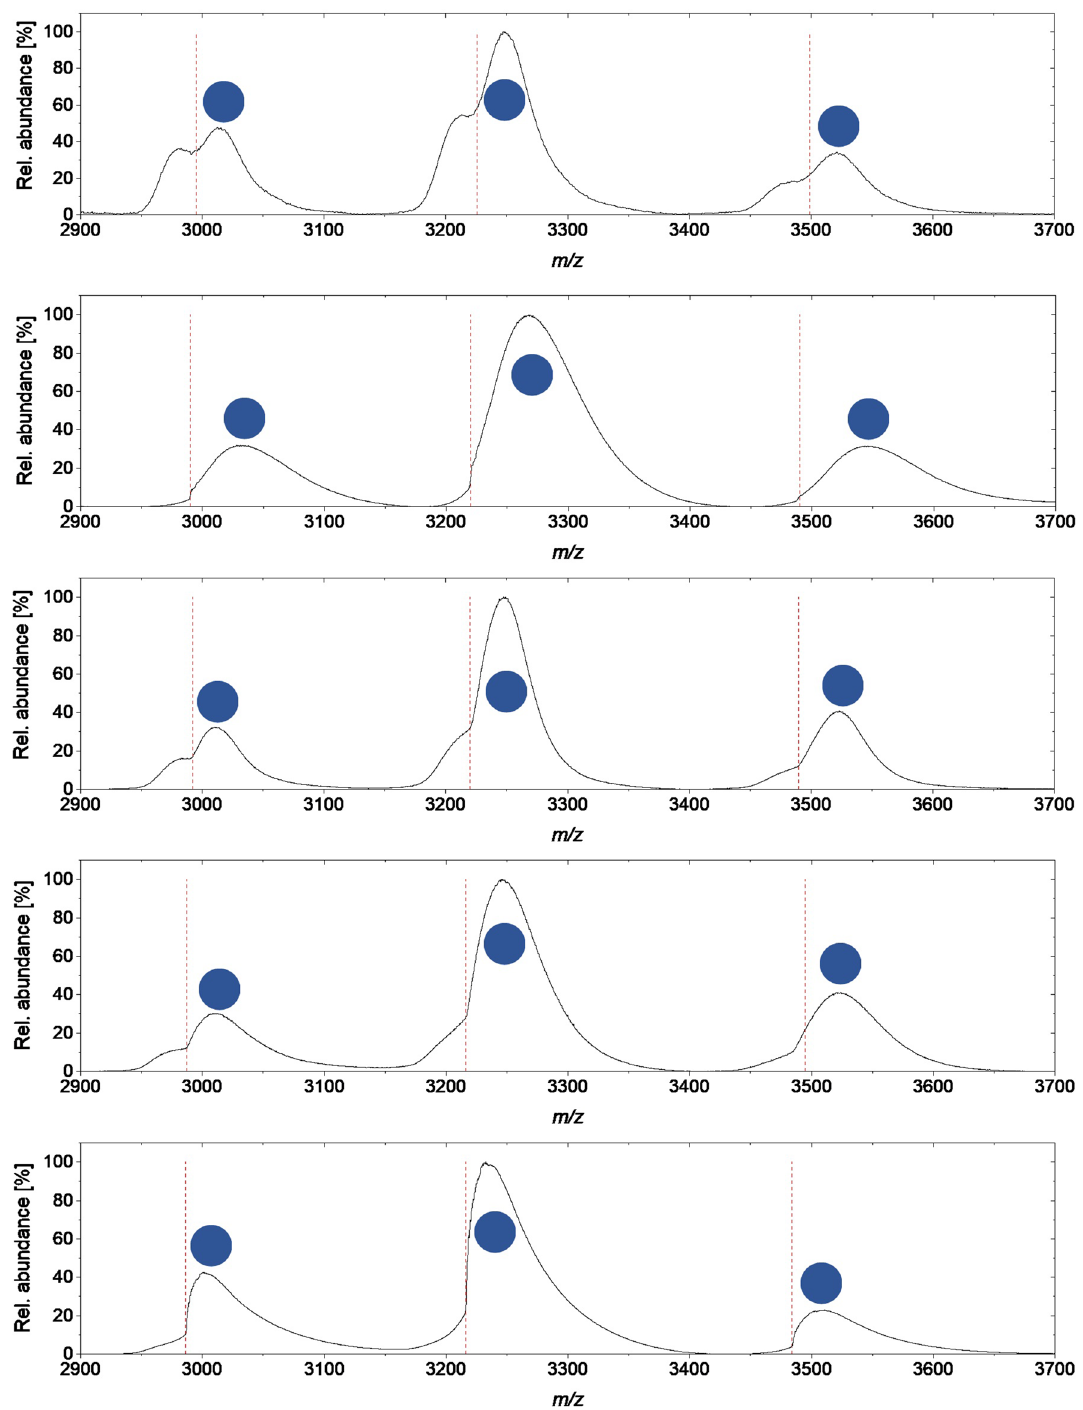
Figure 5. Excerpt of native mass spectra of wild-type OxdB and selected variants (from top to bottom: wild- type OxdB, OxdB_I319E (M1), OxdB_L65H (M9), OxdB_Q250I (M19), OxdB_L65H_I180A (D1). The shown region refers to 2930 and 3520 m/ z , in which the peaks referring to the charge states + 11 to + 13 are displayed. The dashed red lines indicate the separation of the peaks of apoprotein and holoprotein. The blue dots indicate the peaks of the